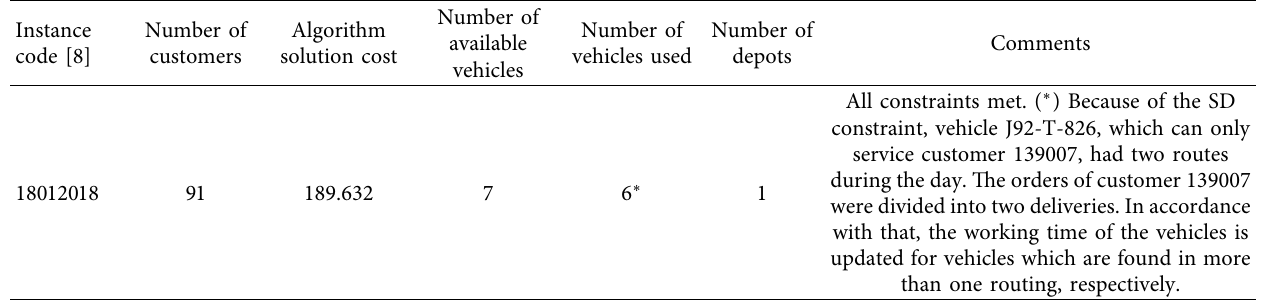
Table 4: Results of testing on real data of a distribution company—divided delivery.